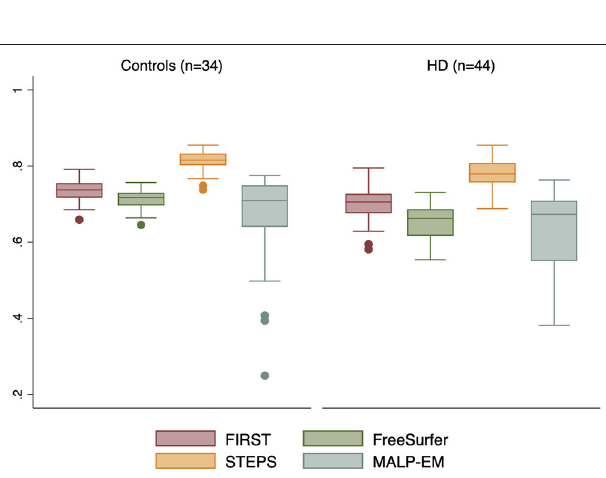
FIGURE 3 | Boxplot demonstrating Jaccard Indices (as a ratio) for each automated method ROI with manual ROI. Boxes show first quartile, median and third quartile with whiskers represent the smallest and largest volumes. Dots represent outliers. STEPS segmented ROIs had larger overlaps with manually segmented ROI in both controls and HD subjects (closest to